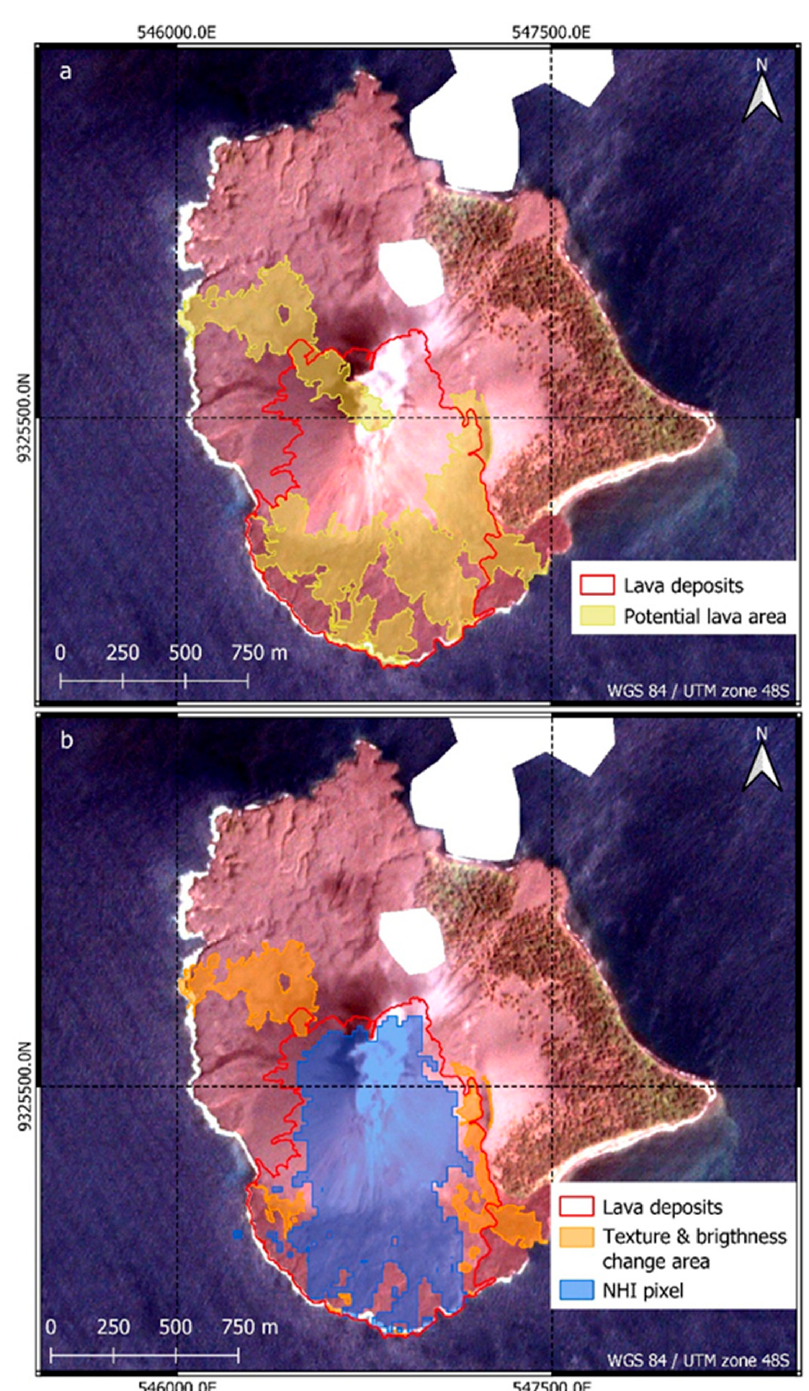
Figure A2. ( a ) Potential lava areas based on distance to the outflow model (Copernicus DEM). All areas in the "potential lava area" class are within 45 m of the nearest point to the extracted drainage flows. ( b ) Areas based on thermal overprinting (NHI area). This area was considered to be volcanically overprinted and thus is certainly covered with lava deposits. It forms the basis for modelling the lava flows in the areas with texture and brightness changes. Areas in the “change area” class were classified using the GLCM and brightness thresholds and are within the “potential lava area” class. Based on the NHI surface, region-growing modelling is performed into the “change area”.